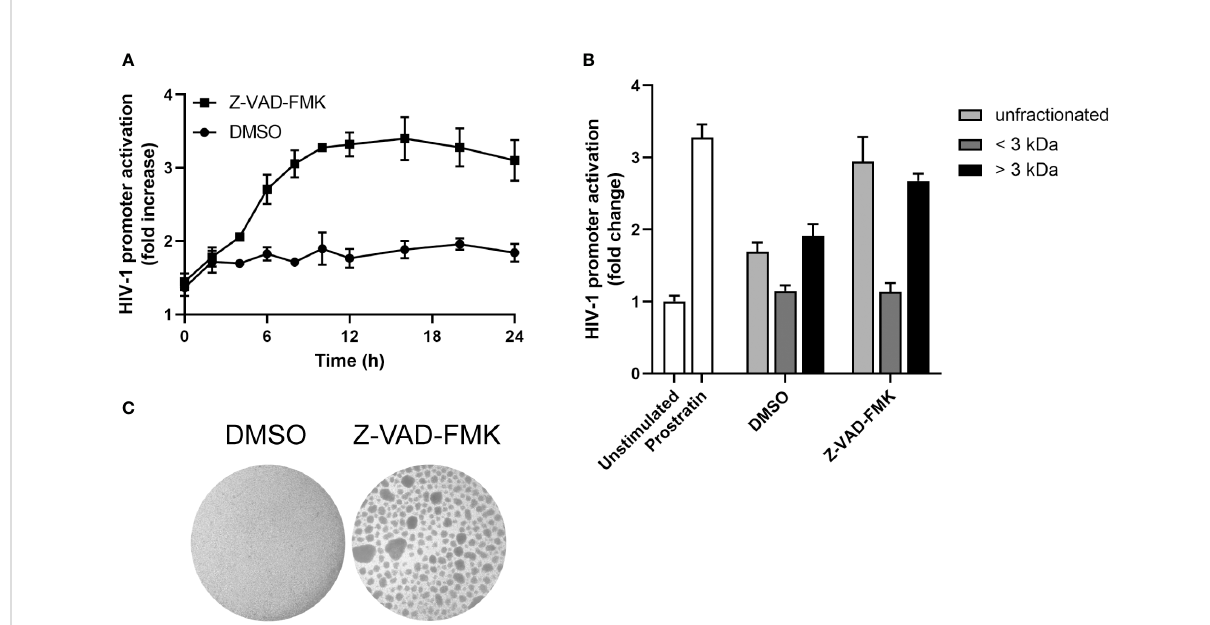
FIGURE 4 Secreted factor of pan-caspase inhibitor-treated NK cells is most likely a cytokine. (A) KHYG-1 cells were incubated with Z-VAD-FMK or only DMSO for various time points after which supernatants were collected and added to TZM-bl cells. Activation of the HIV-1 LTR promoter was assessed by subjecting these cells to a luciferase assay (n=3). Luminescence values of unstimulated cells was set to 1. (B) Supernatants of KHYG- 1 cells were collected and fractionated using columns with a 3 kDa cut-off. Unfractionated or fractionated supernatants were added to TZM-bl cells and analyzed as in (A) (n=3). (C) Light microscopy pictures of KHYG-1 cells treated with Z-VAD-FMK or DMSO for 24 h. For all graphs, data points are plotted as mean ±